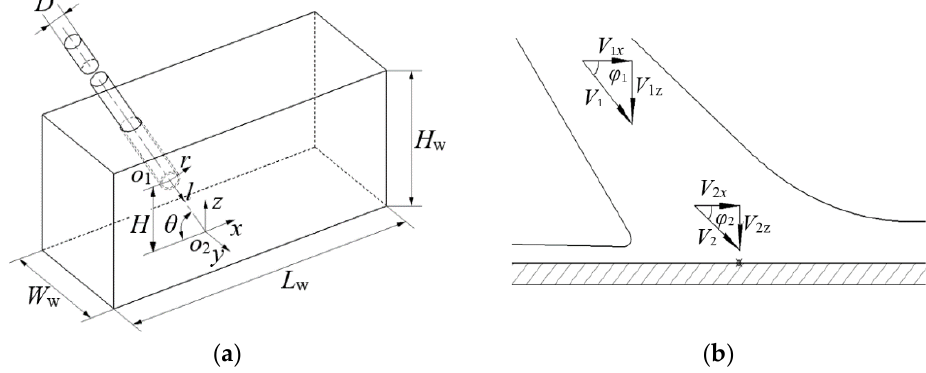
Figure 1. Establishment of calculation model coordinate system: ( a ) three-dimensional diagram of oblique submerged water jet; ( b ) schematic diagram of the flow angle φ on the o 2 xz section.